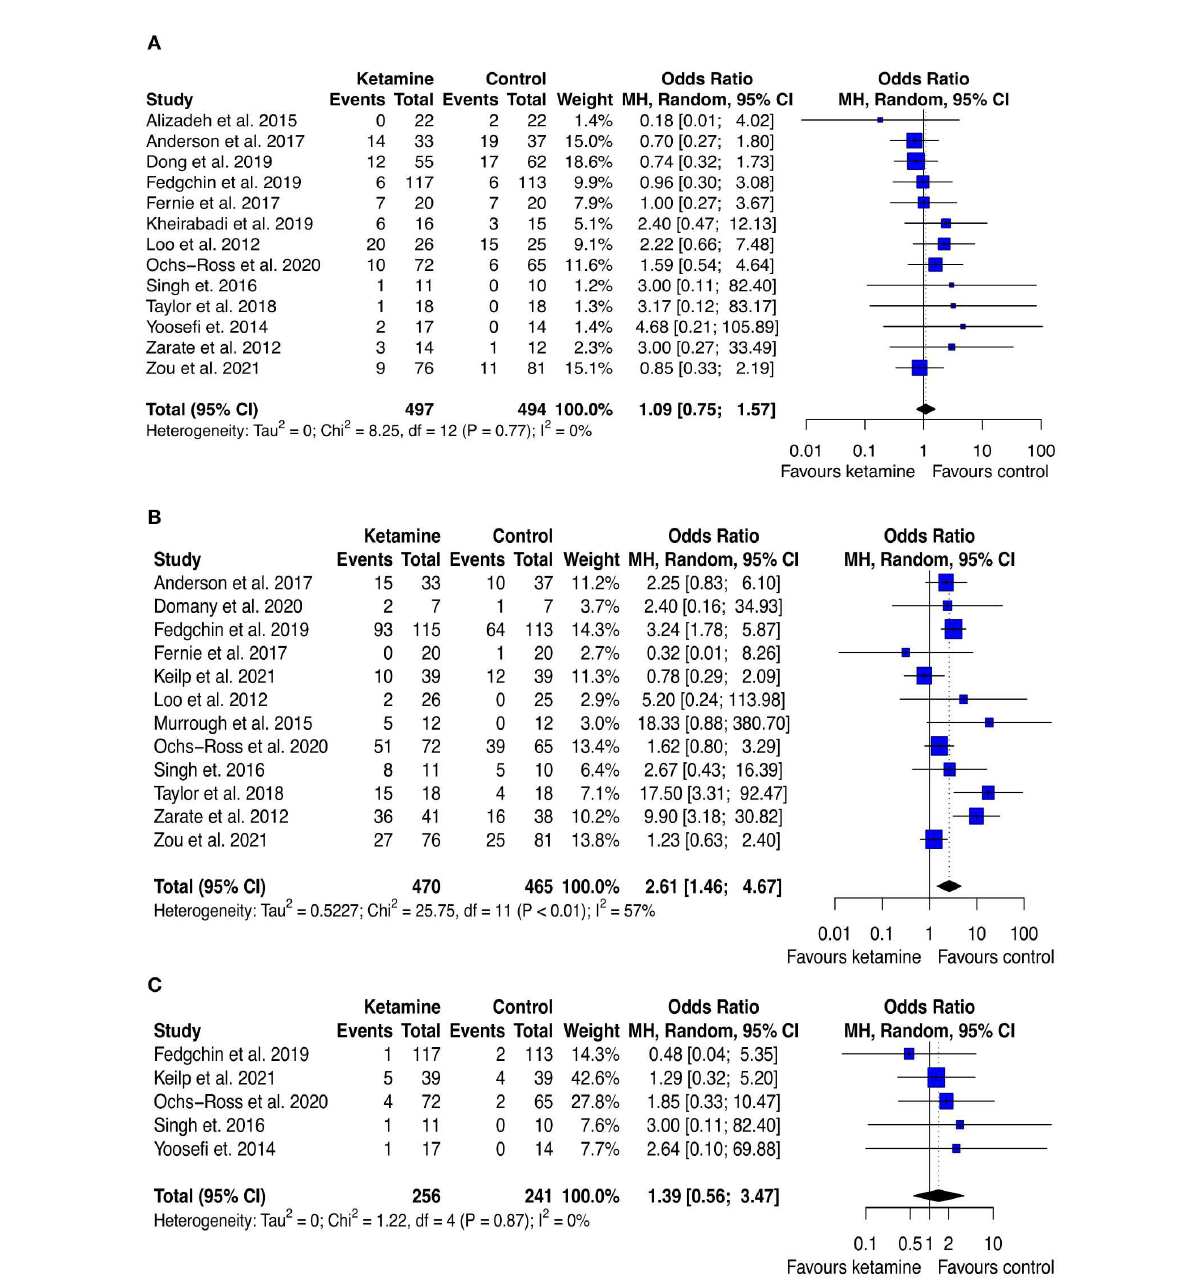
FIGURE8 Forest plots of drop out due to any cause (A) , adverse effect (B) , and drop out due to serious adverse effect (C) among ketamine/esketamine and control groups. SD, standard deviation; MH, Mantel-Haenszel; 95% CI, 95% confidence interval. x axis labels have been edited according to the characteristics of the outcome: since lower rates indicate better safety/tolerability the label “Favors ketamine” is on the left-hand